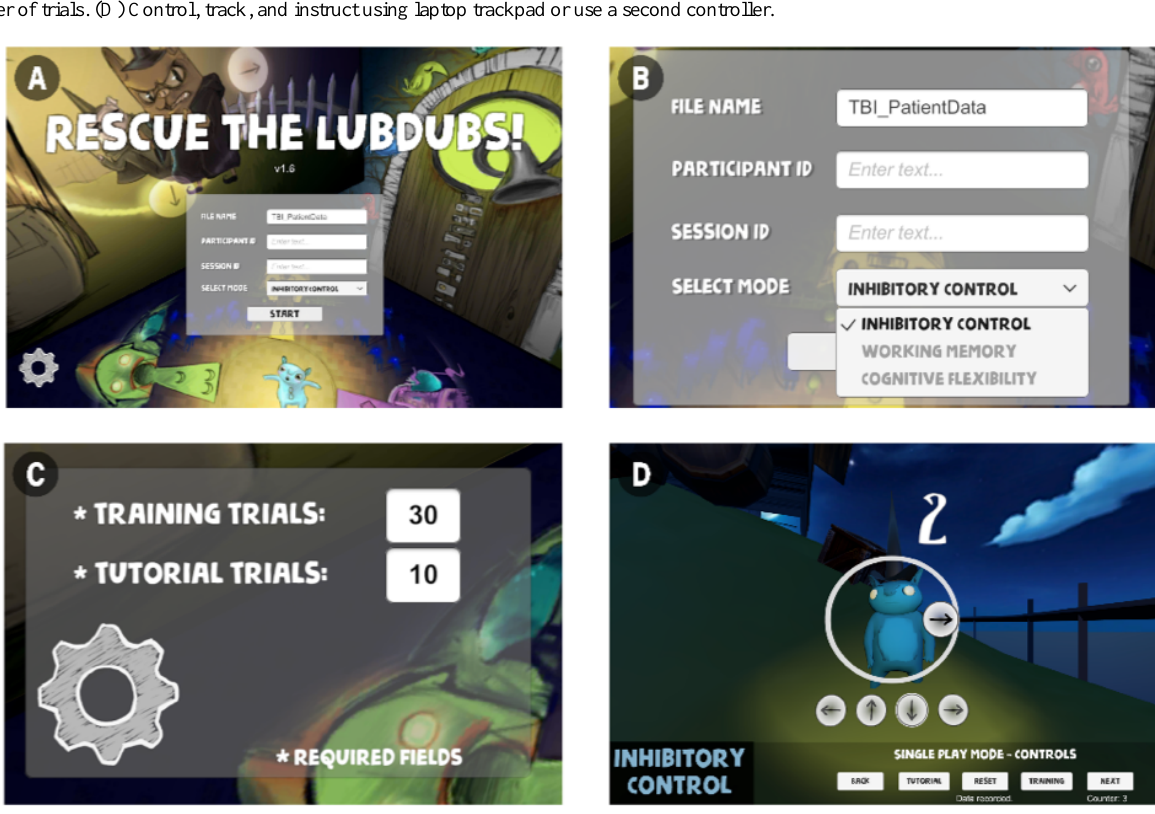
Figure 3. User-friendly interface for therapist. (A) Enter user ID and session ID. (B) Choose training module to run. (C) Customize training by